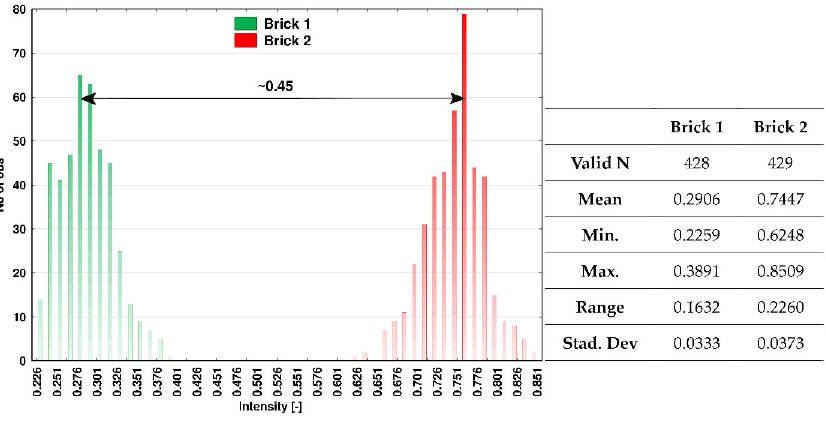
Figure 9. Values of intensity for Brick 1 and Brick 2 .